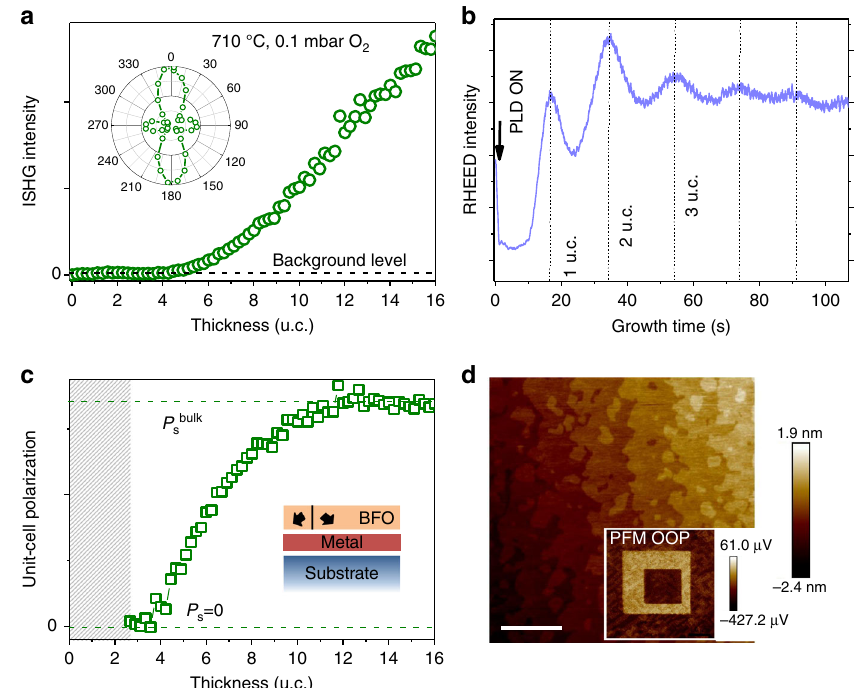
Fig. 2 In fl uence of ferroelectric domain pattern on the evolution of polarization. a In situ second harmonic generation (ISHG) intensity dependence of BiFeO 3 (BFO) fi lm thickness during the pulsed laser deposition growth of epitaxial BiFeO 3 | SrRuO 3 || DyScO 3 (Methods section). The inset shows the polarization anisotropy of the ISHG yield (varying the polarization of the incident fundamental light and measuring a fi xed polarization component at 0° of the emitted ISHG light) at a BFO thickness of 16 unit cells. As explained in the main text, the polarization dependence identi fi es a ferroelectric stripe- domain structure 19 . b Re fl ection high energy electron diffraction (RHEED) measured in parallel to the ISHG yield. c Unit-cell polarization as a function of thickness, derived and plotted as in Fig. 1. d Topography and out-of-plane piezoresponse force microscopy (PFM OOP) in the inset of a BFO fi lm of 20 unit cells. The scale bar corresponds to 1 µ